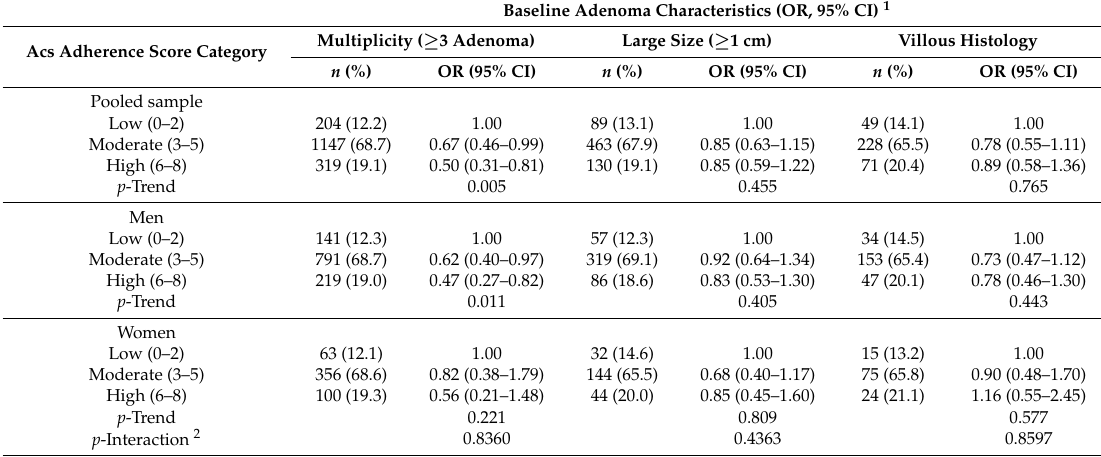
Table 3. Adjusted ORs (95% CI) for the association between category of guideline adherence and baseline colorectal adenoma characteristics for pooled sample and by sex and